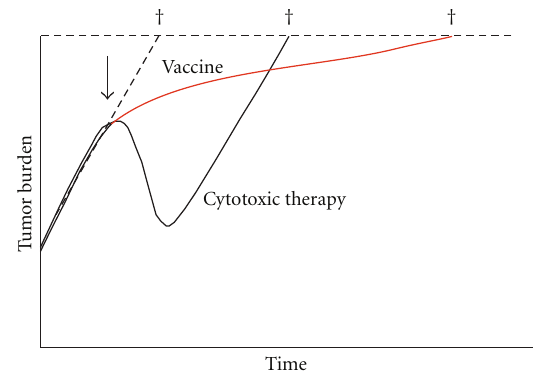
Figure 3: Tumour growth is a dynamic biologic process, that is, the net result of cells dividing and other cells dying. Intrinsic tumour biology, as well as extrinsic factors such as therapies, a ff ects the tumour’s growth rate. However, chemotherapy only a ff ects the tumour growth rate while it is being administered, which may result in a dramatic but transient response. Following discontinuation of chemotherapy, the growth rate returns to its pretreatment slope, driven by the underlying biology of the tumour. Immunotherapy (red line), on the other hand, can alter the biology of the host by inducing an active antitumour immune response including a memory response. This may not cause an immediate or dramatic change in tumour burden, but continued cumulative slowing pressure on tumour growth rate, especially if started early in the disease course, which may lead to substantially longer overall survival. The arrow indicates the initiation of treatment; cross indicates time of death from cancer [48]. (Figure used with permission from